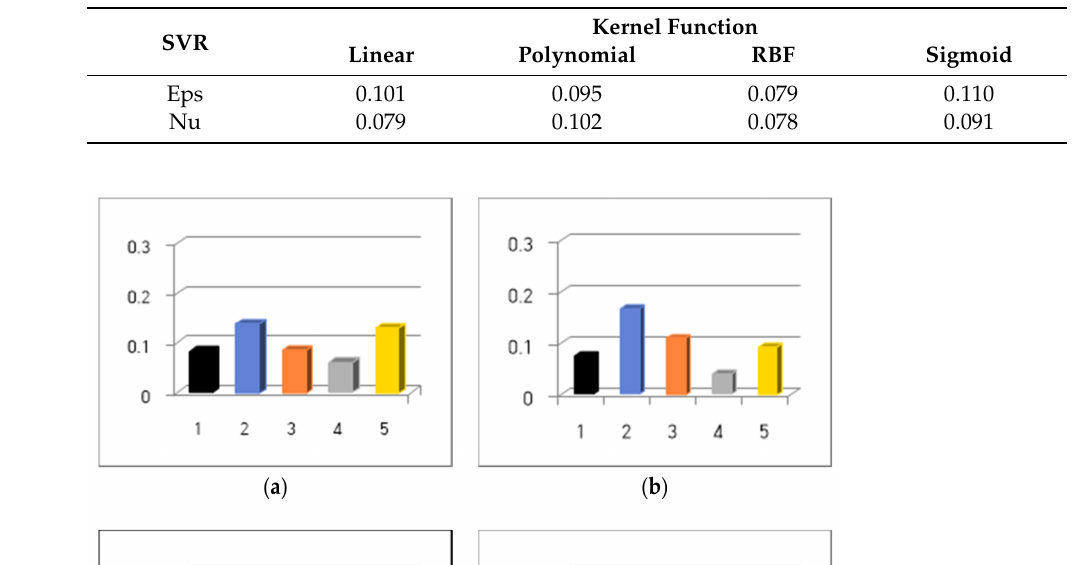
Table 1. Comparison of the convergence rates of the dementia severity predictive model according to the support vector machine regression (SVR) and kernel function.